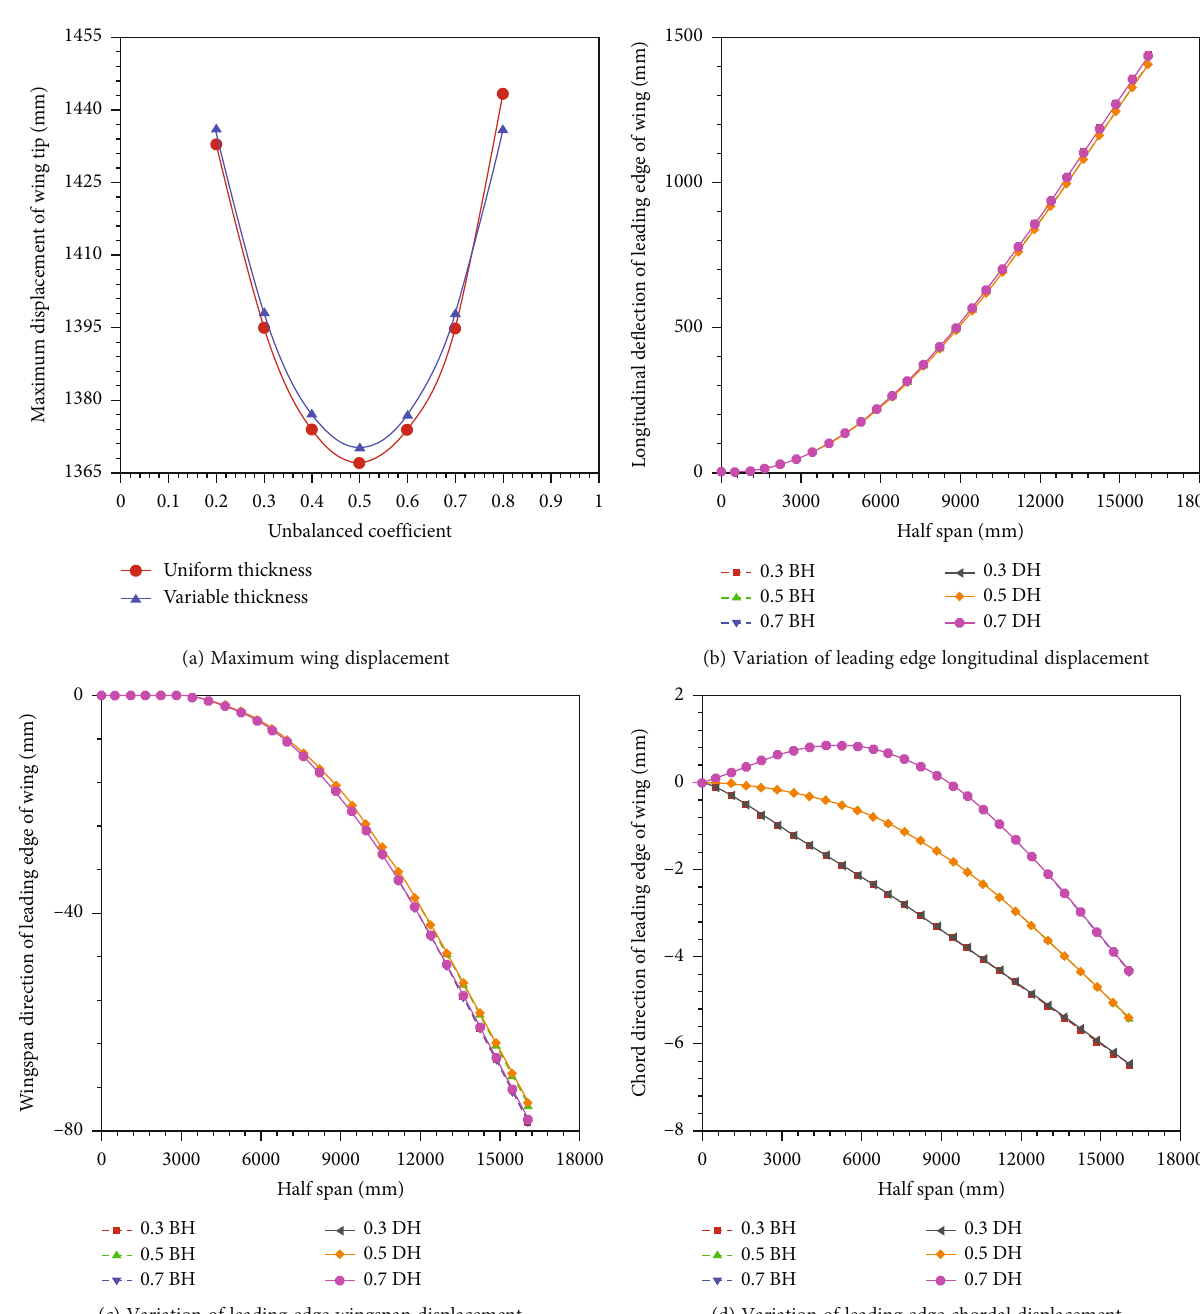
Figure 10: Deformation of airfoil with changing thickness layup.